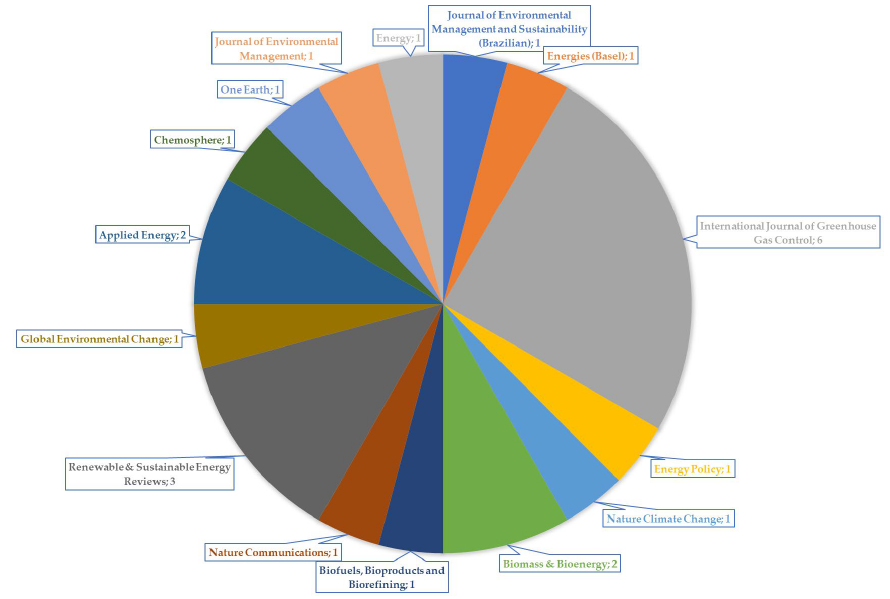
Figure 3. Number of included articles based on the journal in which they were published. Source: author’s elaboration.